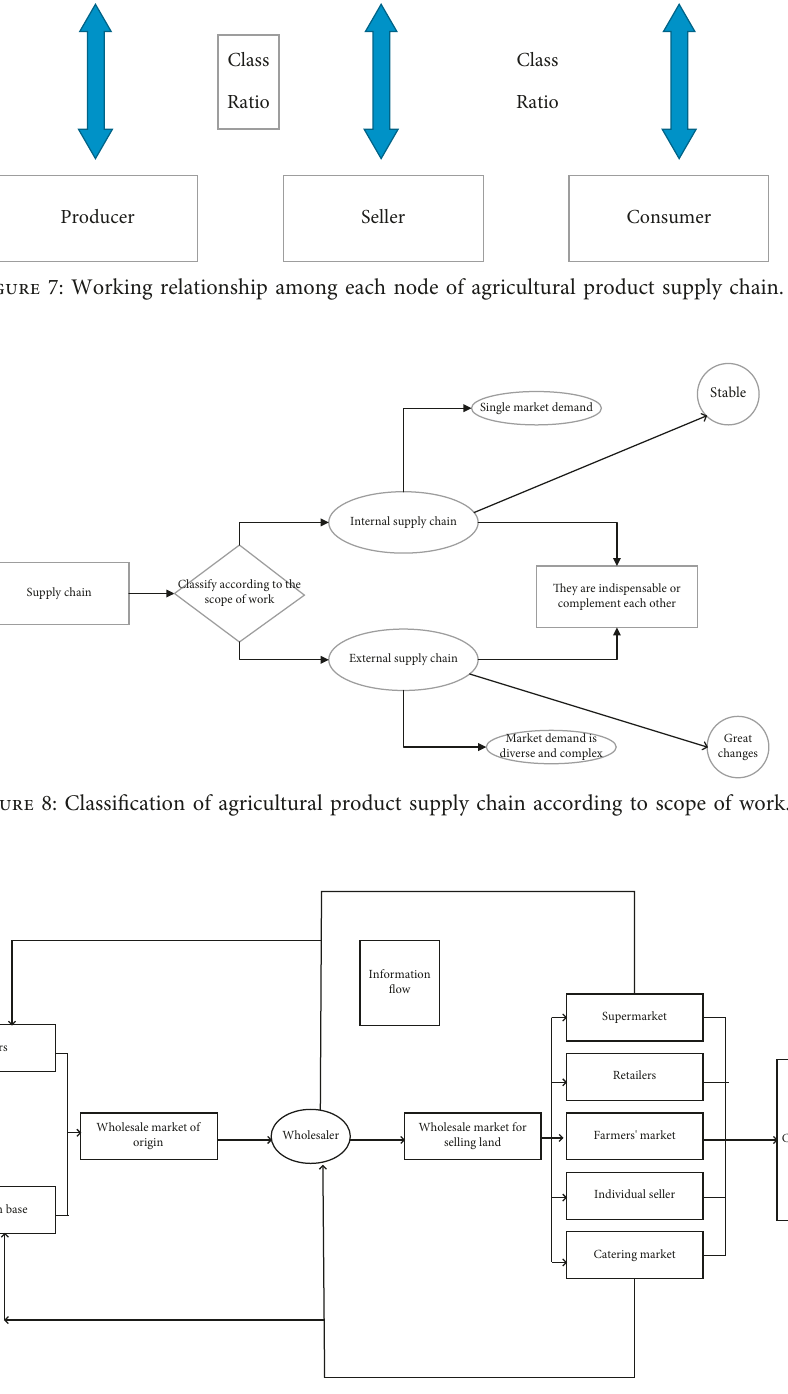
Figure 9: Traditional agricultural product supply chain management